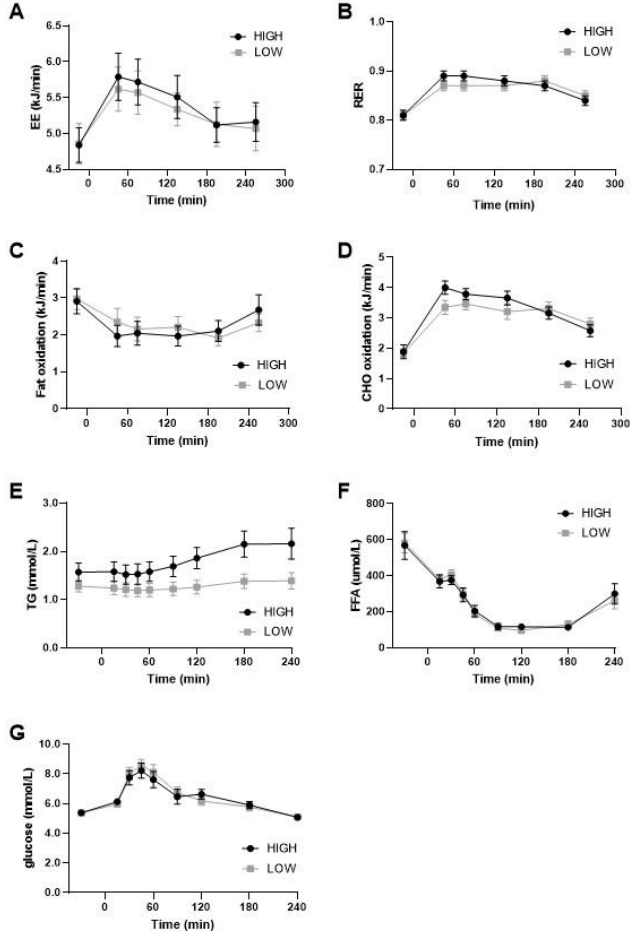
Figure 3. Energy expenditure, substrate oxidation, and plasma values during meal test after two weeks of a high- or low-GI/SFA diet. ( A ) Energy expenditure (EE). ( B ) Respiratory exchange ratio (RER). ( C ) Fat oxidation. ( D ) Carbohydrate (CHO) oxidation during the meal test after two weeks of a high- or low-GI/SFA diet ( n = 10). ( E ) Plasma triglycerides levels, significant effect of diet and diet × time p < 0.05. ( F ) Plasma-free fatty acids. ( G ) Plasma glucose ( n = 10).